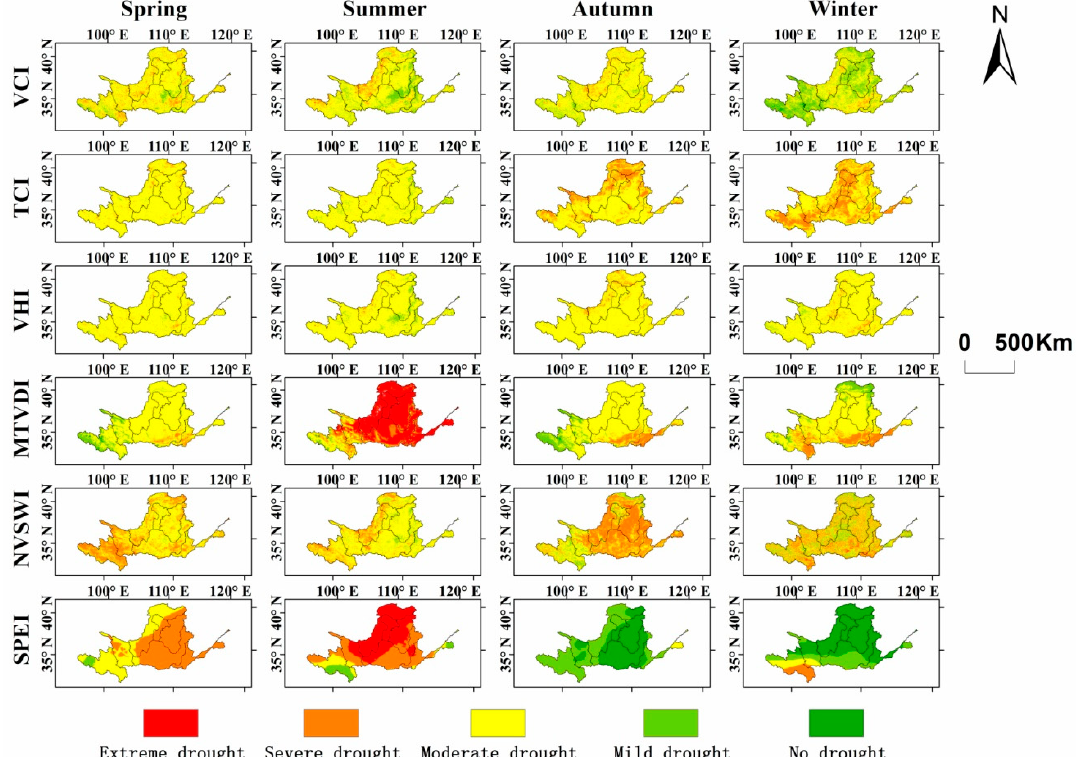
Figure 6. Spatial distribution of seasonal drought in the Yellow River basin (YRB).